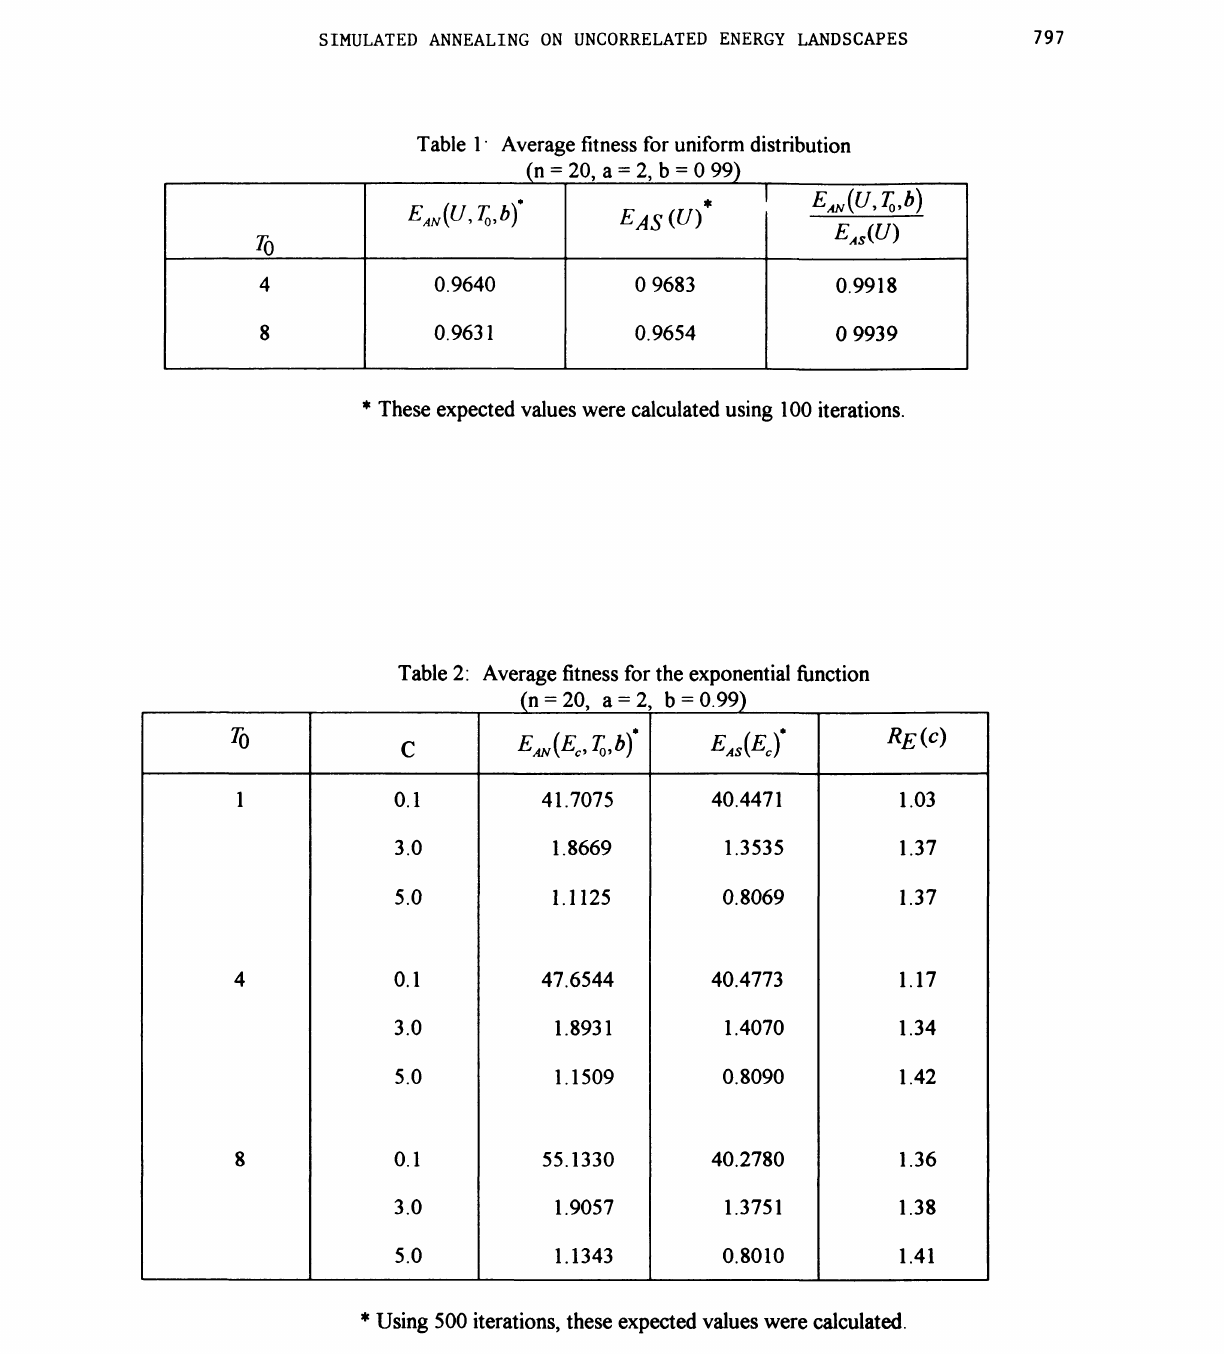
Table 1 Average fitness for uniform distribution